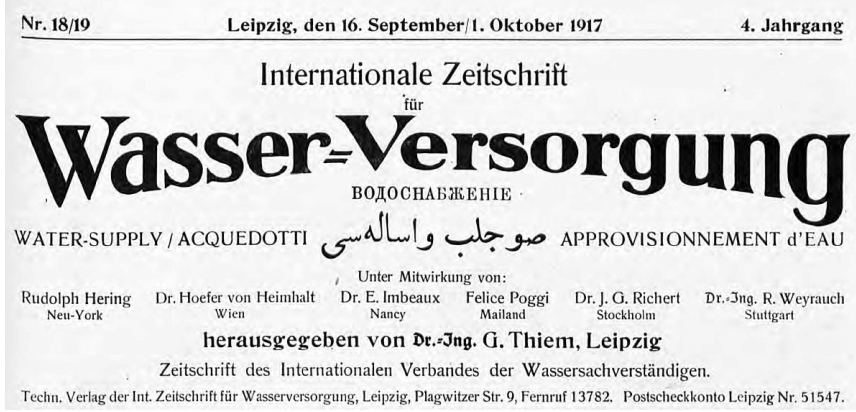
Figure 10. Header of the Internationale Zeitschrift für Wasser-Versorgung (1917), showing the international co-editors and the journal title in different languages.